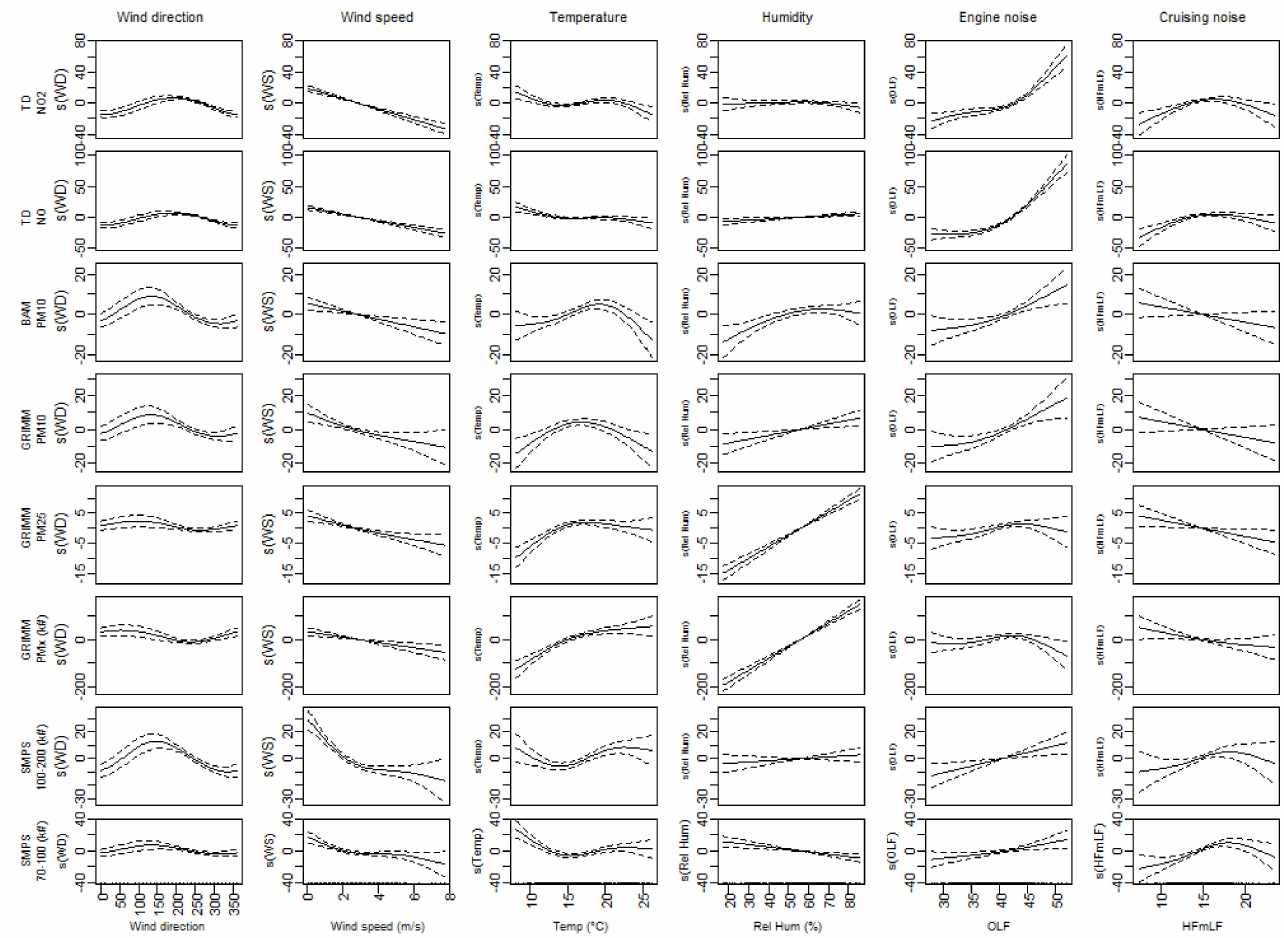
Figure 9. Selection of the extended noise-air pollution GAM models that include temperature and relative humidity: NO 2 , NO, PM10 (BAM); PM10, PM2.5 and PMx (GRIMM); UFP count 100–200 nm and 70–100 nm